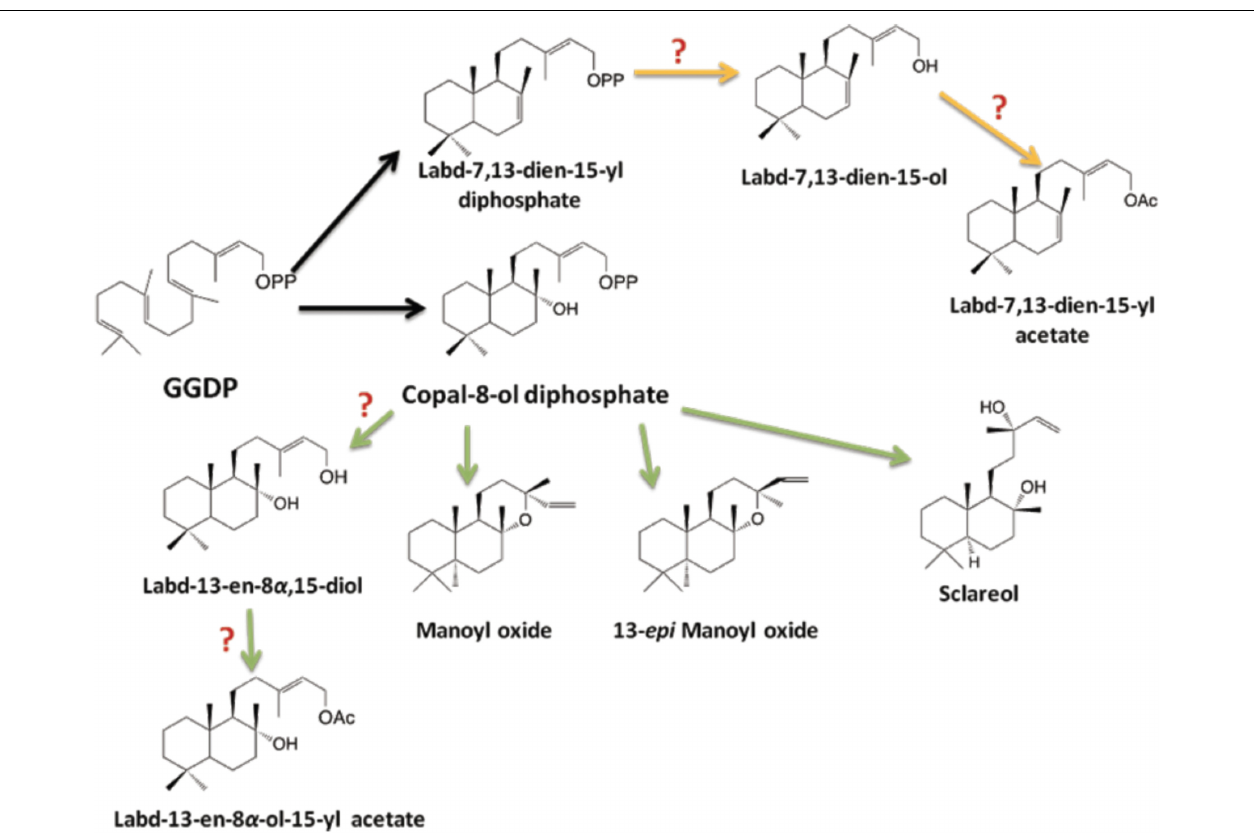
FIGURE 2 | Proposedpathwaytolabdane-typediterpenespredominantin C. creticus resin. A protonation-initiated cyclization catalyzed by CcCLS converts GGDP to the stable bicyclic intermediate copal-8-ol diphosphate. A second ionization-initiated cyclization of copal-8-ol diphosphate results in the formationofmanoyloxideisomers,whilelabd-13-en-8 α ,15-diolcouldbeformed either by phosphatase activity or type A diterpene synthase activity. Similarly a